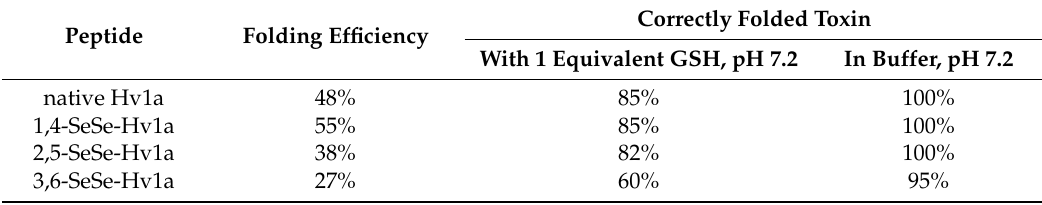
Table 1. Accumulation of correctly folded toxin during folding and susceptibility of the native and diselenide Hv1a to